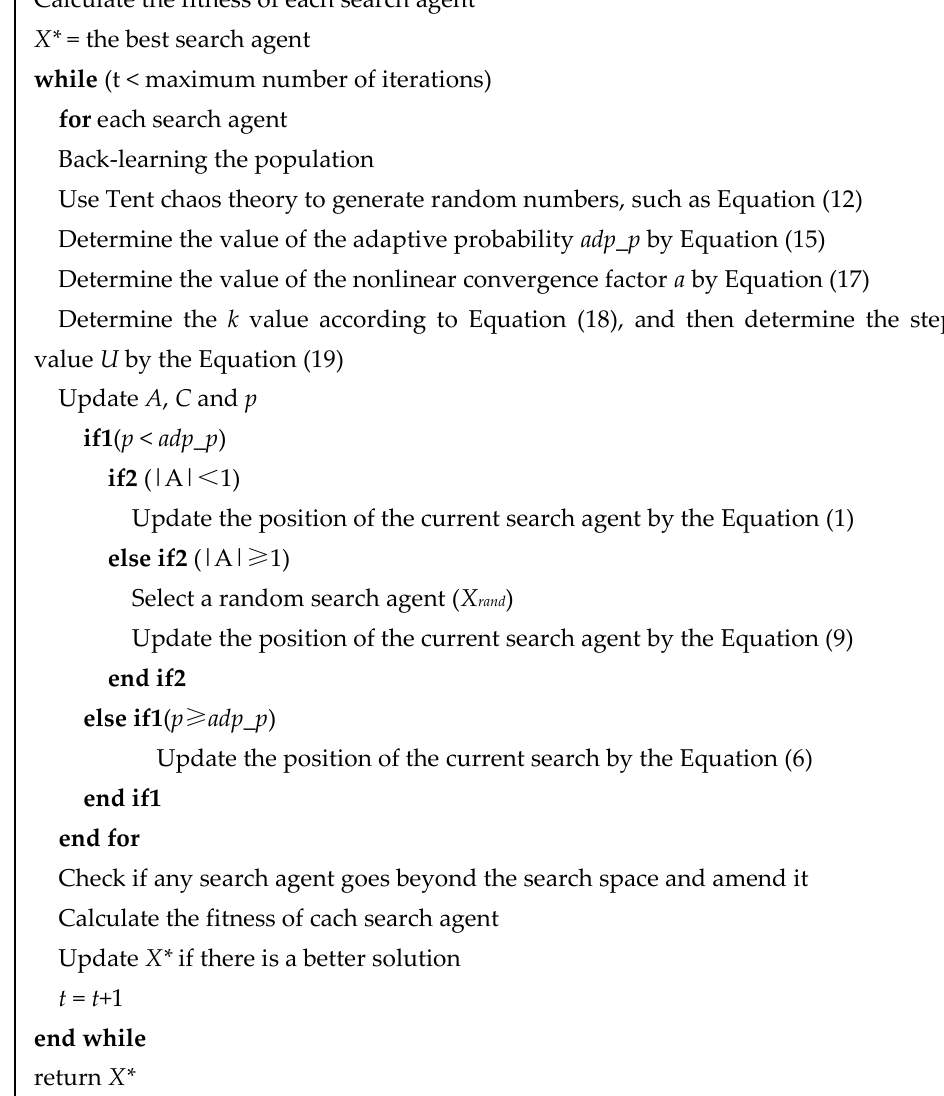
Figure 5. IWOA implementation pseudocode.